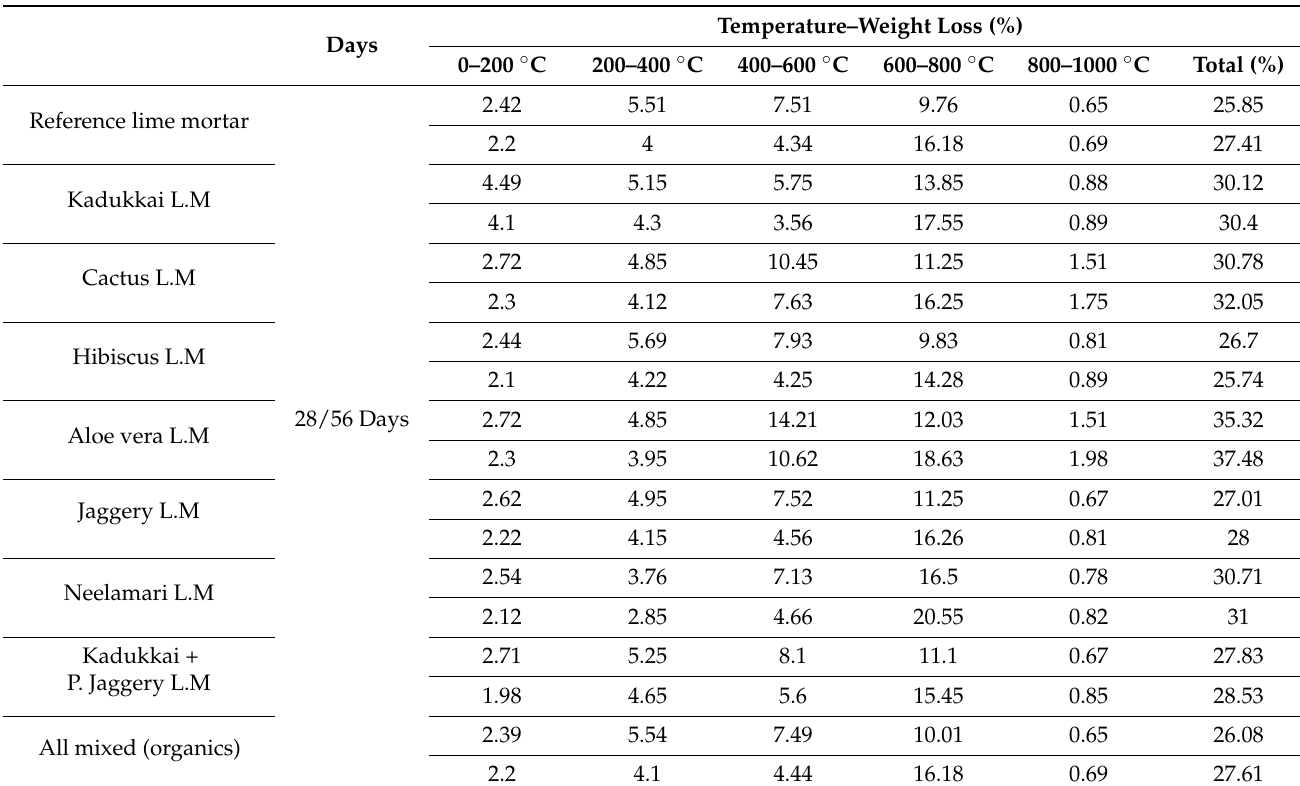
Table 4. TG-DTA weight loss of the lime mortar